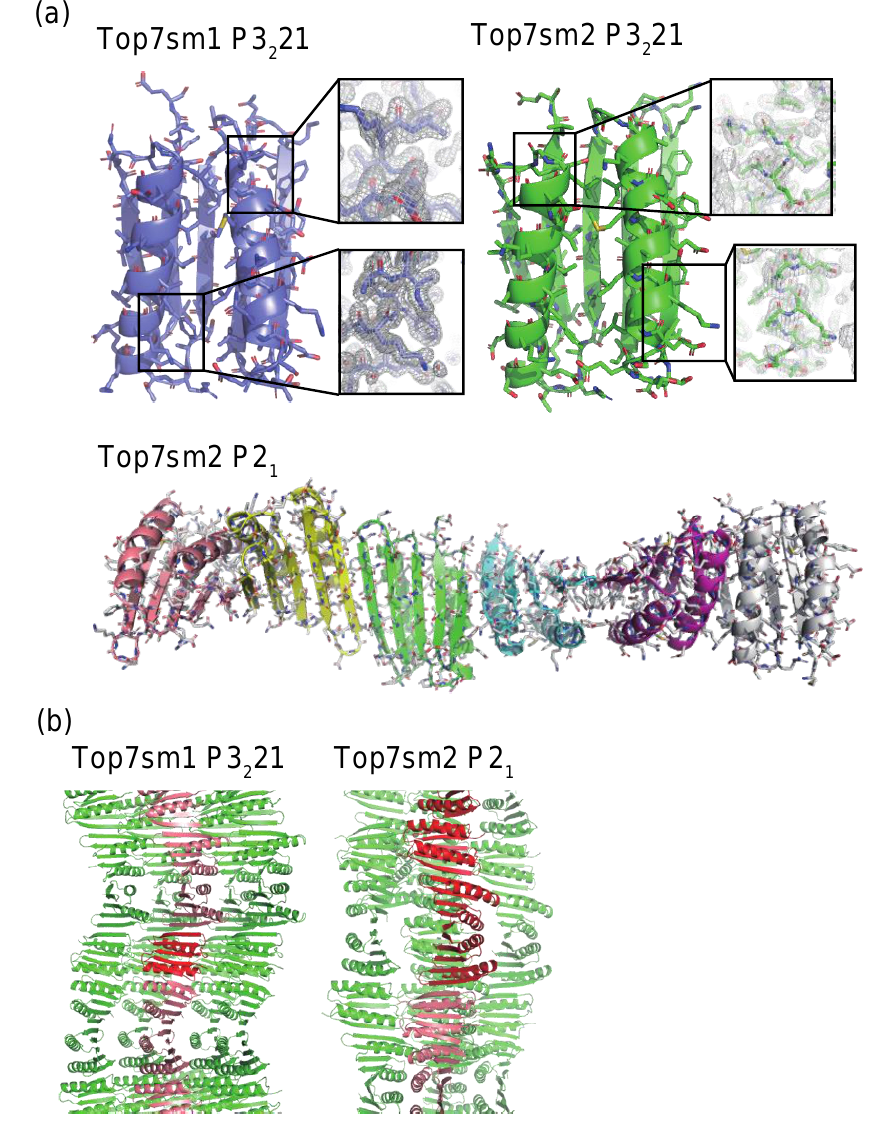
Figure 2. Crystal structures of Top7sm1 and Top7sm2. ( a ) Protein structures in asymmetric units are shown with cartoon and stick representations. Six monomers in the asymmetric unit of the Top7sm2 P2 1 crystal are shown by six different colors. Electron density maps (contour level of σ = 1.0) for P3221 crystals are shown in rectangles with mesh representations. ( b ) Crystal packings of Top7sm1 P3 2 21 and Top7sm2 P2 1 . Proteins in the asymmetric units are shown in red. One-directional arrays via intermolecular β -sheet are indicated with salmon color of symmetry-related molecules.